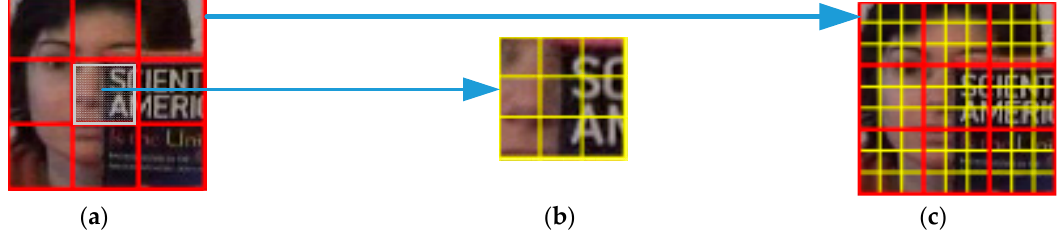
Figure 1. Target region division. ( a ) Sampling patches; ( b ) sampling sub-patches; ( c ) a patch distribution map.